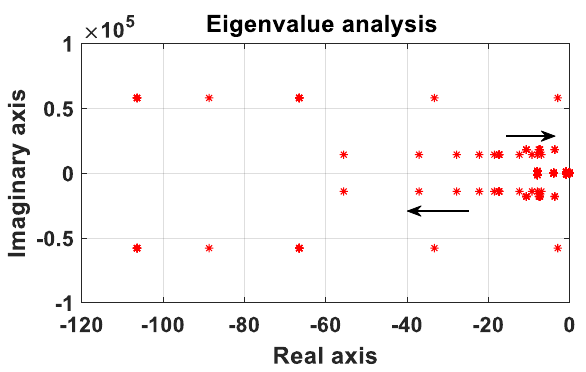
Figure 8. Impact of the variation in load power on the DC grid. Table 6. Damping performance of complete system under different loads.